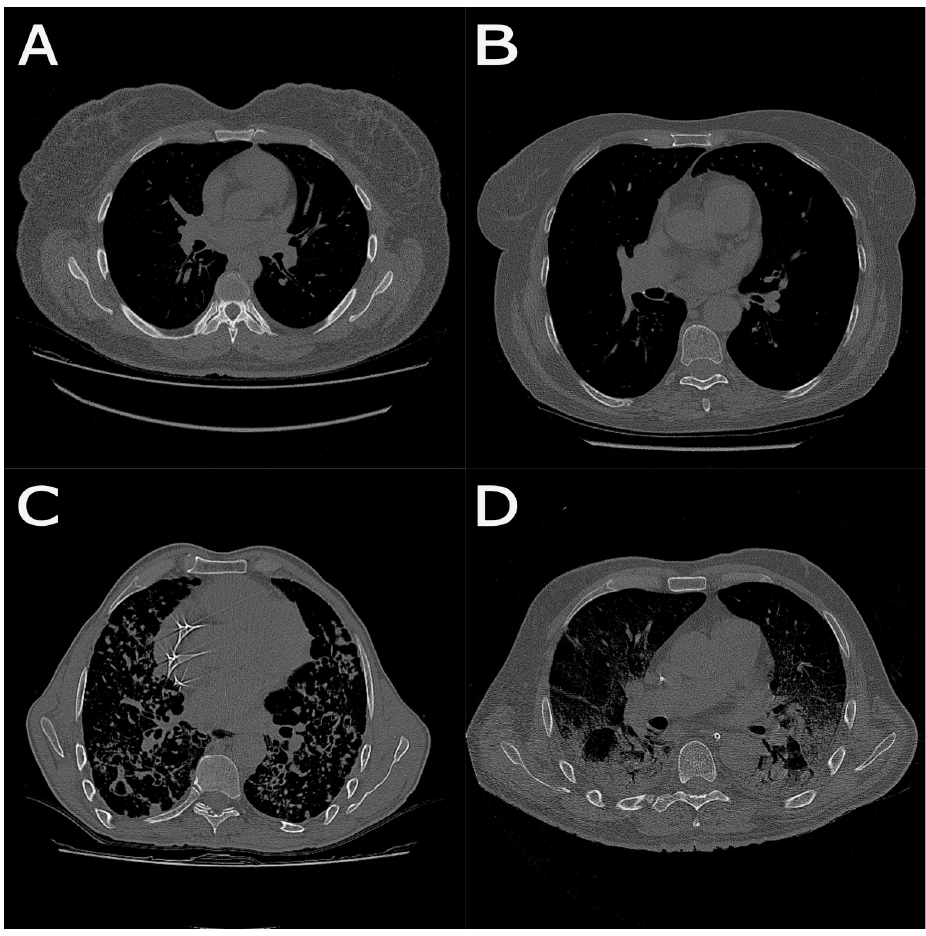
Fig 1. Different slices of CT scans representing each patients group. A– No lung disease , B–COPD, C–PCM and D—